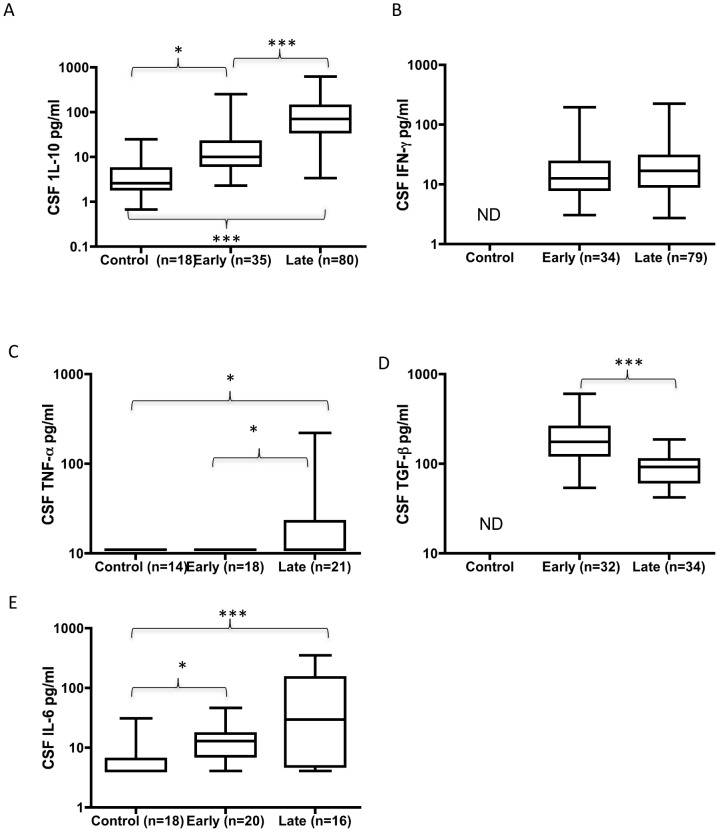
CSF cytokine concentrations in HAT.IL-10 (a), IFN-γ (b), TNF-α (c), TGF-β (d) and IL-6 (e) concentrations in control, early and late stage HAT patients. Boxes indicate median and interquartile range, and whiskers represent 10th and 90th percentiles. ***p<0.001; *p<0.05 Mann-Whitney U test. BLD = below limit of detection. ND: Not analysed due to insufficient material.